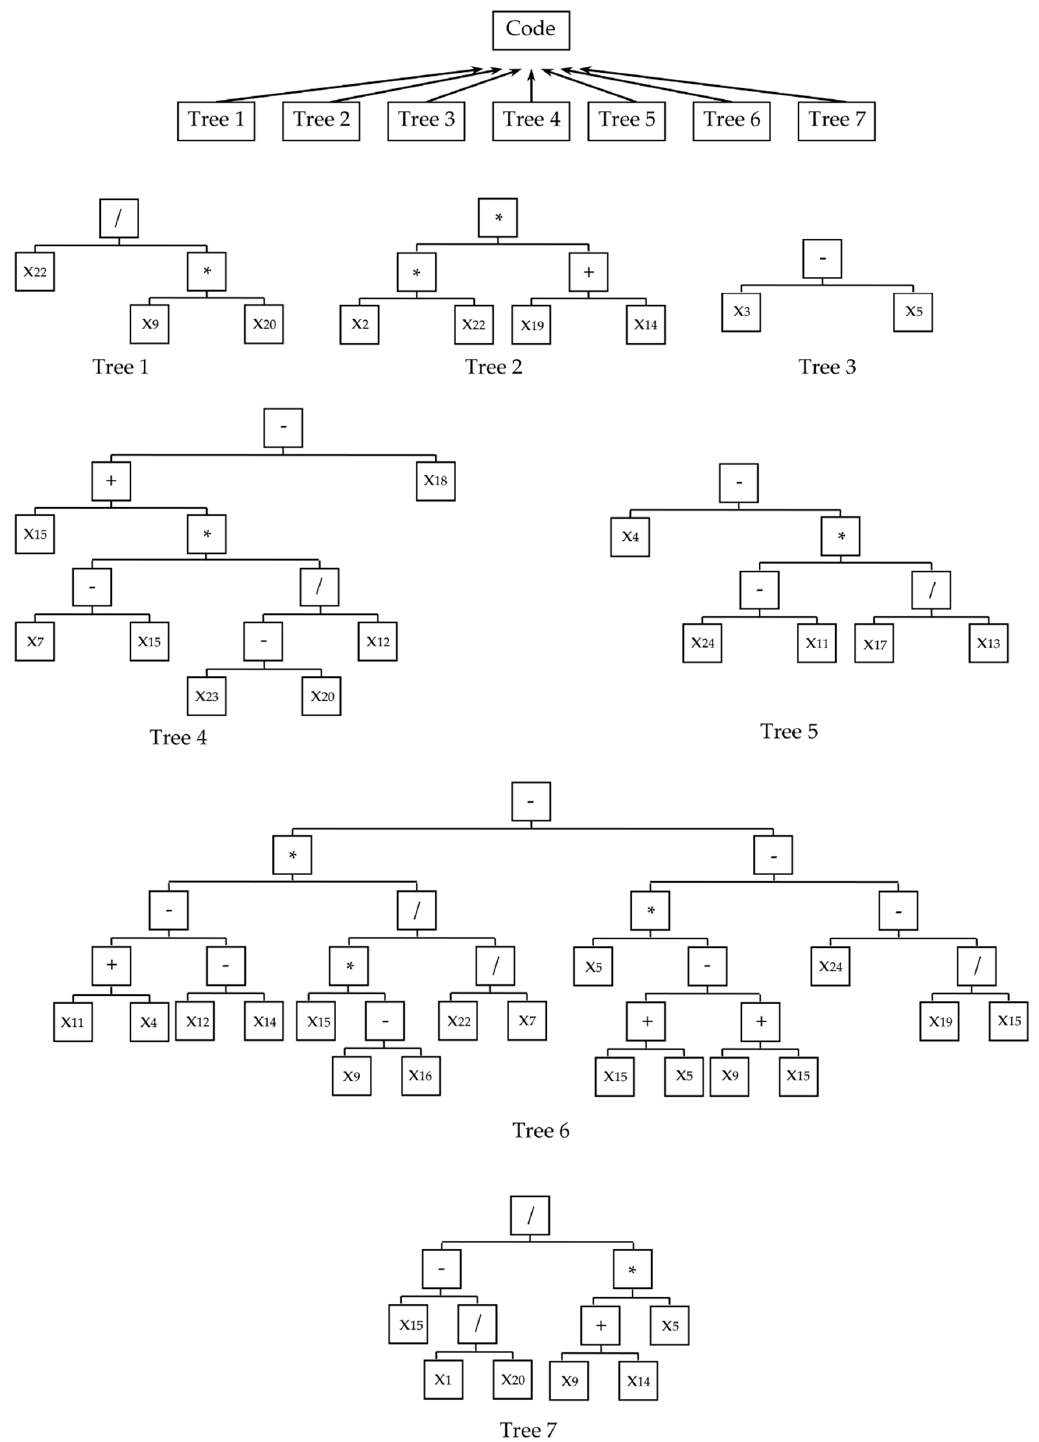
Figure 16. Best Model of ABCP-Descriptor for DS-Kylberg Table 7. Equations of Subtrees of Best Model of ABCP-Descriptor for DS-Kylberg.